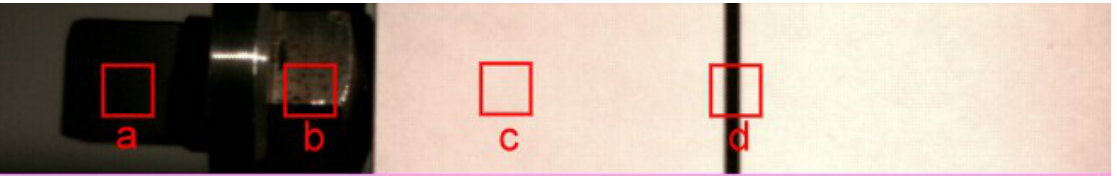
Figure 5. The gray level summation data of the four squares of Figure 2: ( a ) data of the leftmost square in a region of the accelerometer. ( b ) data of the second left square in another region of the acceleration. ( c ) data of the square in the left part of the white paper. ( d ) data of the rightmost square in the central part of the white paper and covering a black